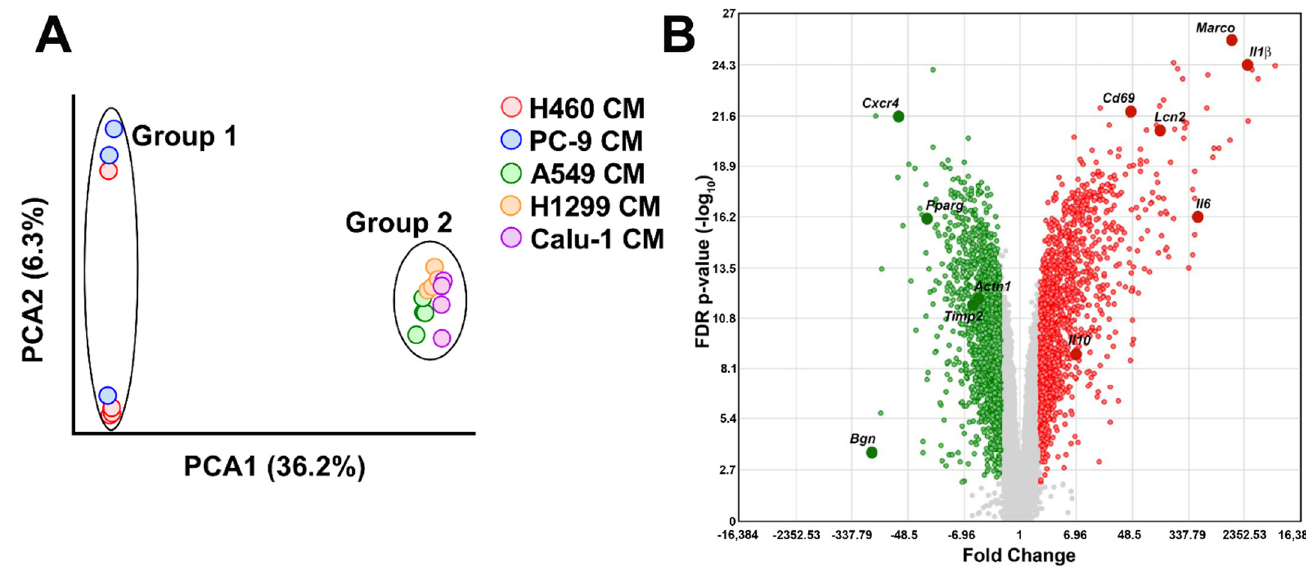
Figure 1. Impact of NSCLC cell line CMs on BMDMs gene expression profile. ( A ) Global representation of normalized gene expression profile data of BMDMs exposed to the different CMs by PCA. Experimental groups segregated into two clusters defined as Group 1 (H460- and PC9-CMs stimulated macrophages) and Group 2 (A549-, H1299- and Calu-1-CMs stimulated macrophages). Each dot represents a sample. ( B ) Volcano plot of transcripts with FDR < 0.01 and − 2 ≤ FC ≥ 2 resulted from the comparison between Group 1 and Group 2 BMDM gene profile data. In total, 1420 and 1626 transcripts are up- (red dots) and down-regulated (green dots), respectively. Plot shows the Fold Change on the X -axis versus FDR p -value (on a log10 scale) on the Y -axis. NSCLC: Non-small cell lung cancer; BMDMs: bone marrow-derived macrophages; PCA: principal component analysis.